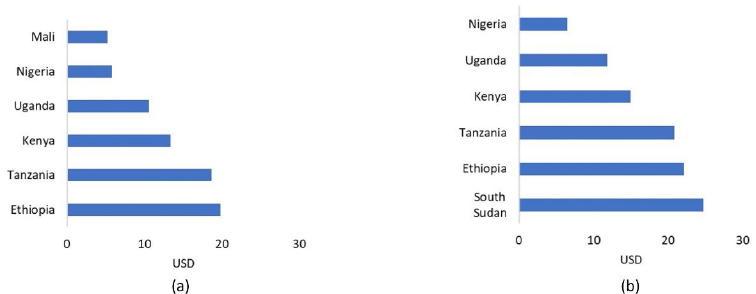
Figure 4. Estimated annual market values in millions of dollars for new interspecific Urochloa ( a ) and Megathyrsus maximus ( b )